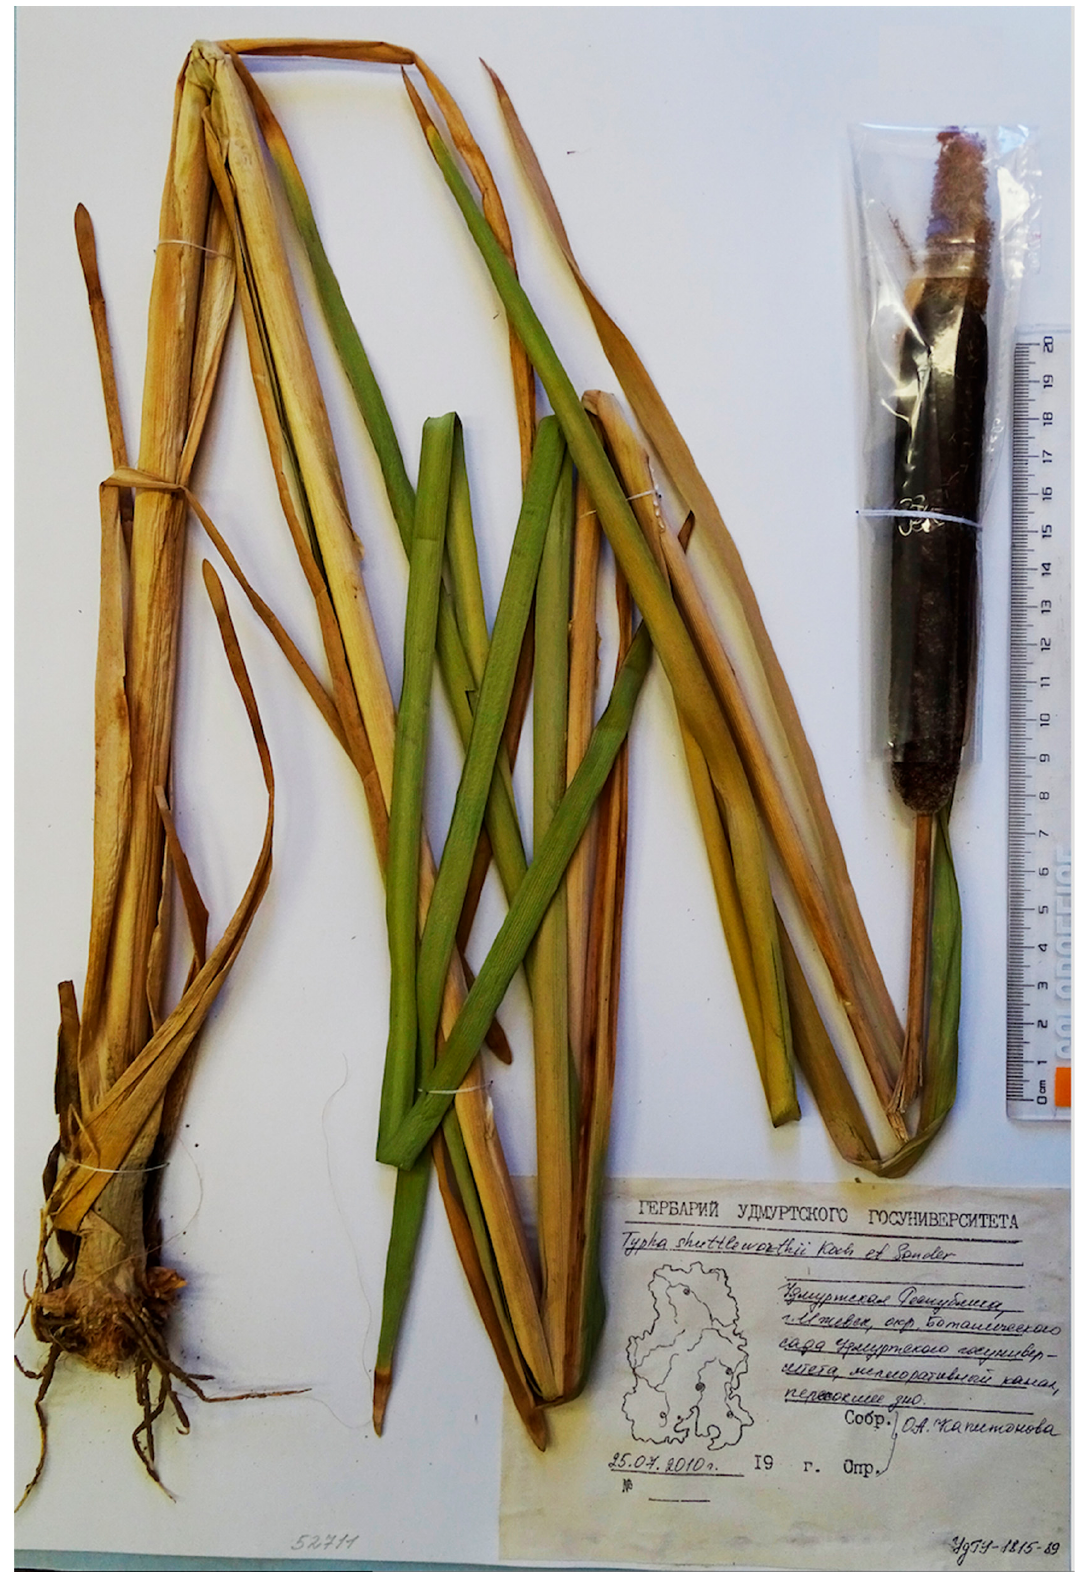
Figure 1. Typha lepechinii sp. nov: holotype, IBIW (unique collection number: 52711). Photo: E. A.